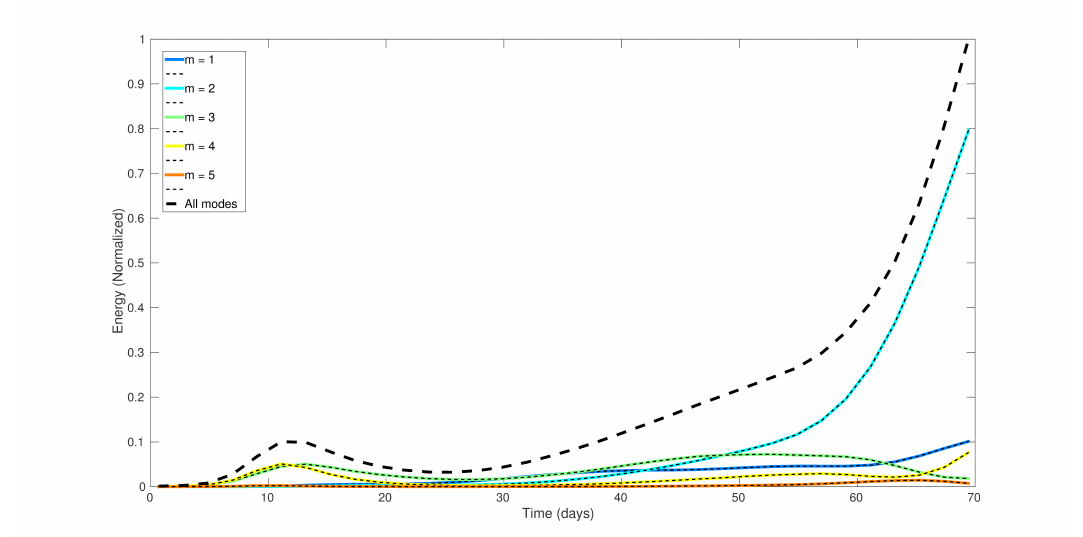
Figure 11. Time evolution of the azimuthal decomposition of the optimal perturbation for a time interval τ = 17 days integrated in the non-linear QG model. The discontinuous black line shows the total